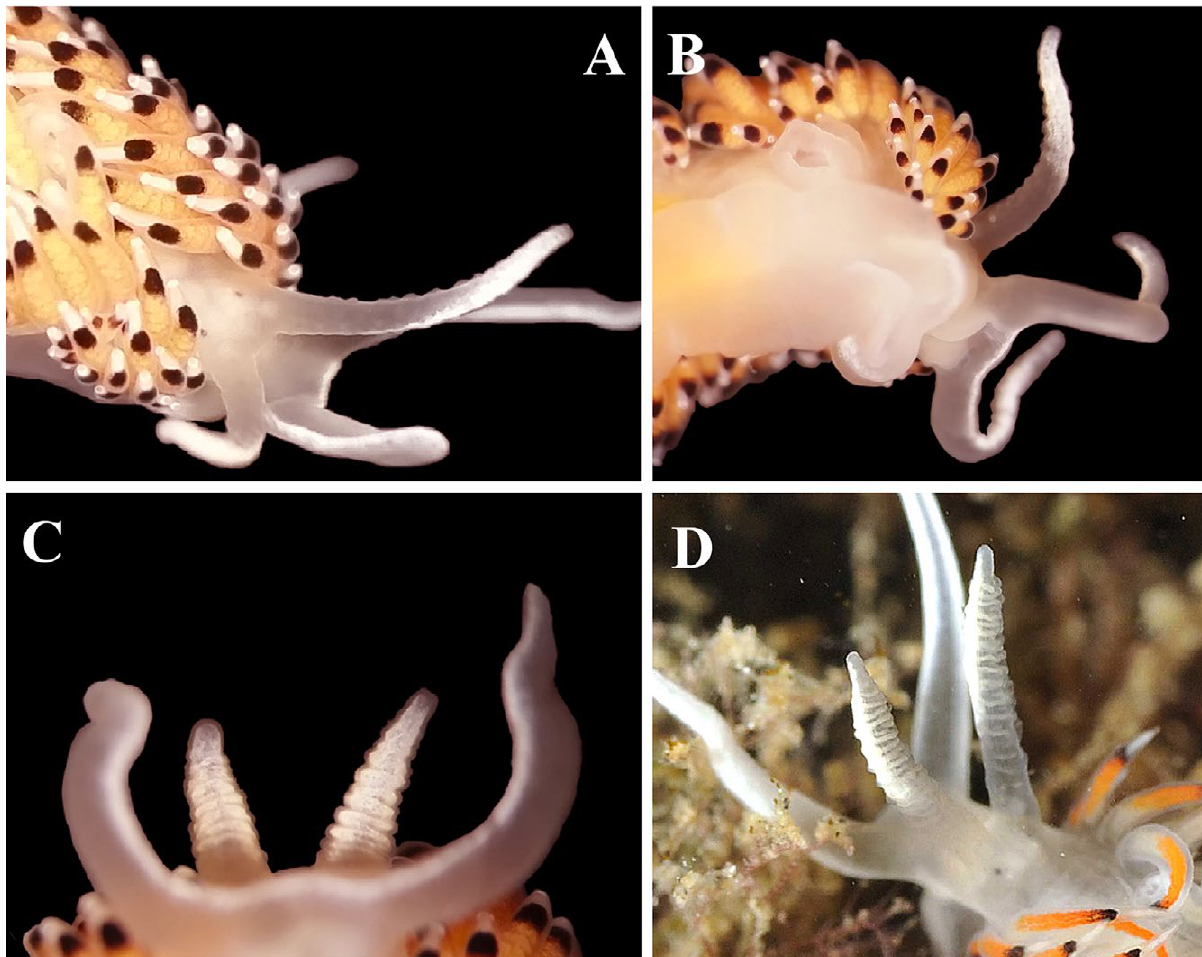
Fig. 4. – Rhinophore morphology of C. elegans (A-C) and F. quatrefagesi (D). A, B, extended rhinophores; C, contracted rhinophores. D, detail of the lamellate rhinophore of F. quatrefagesi